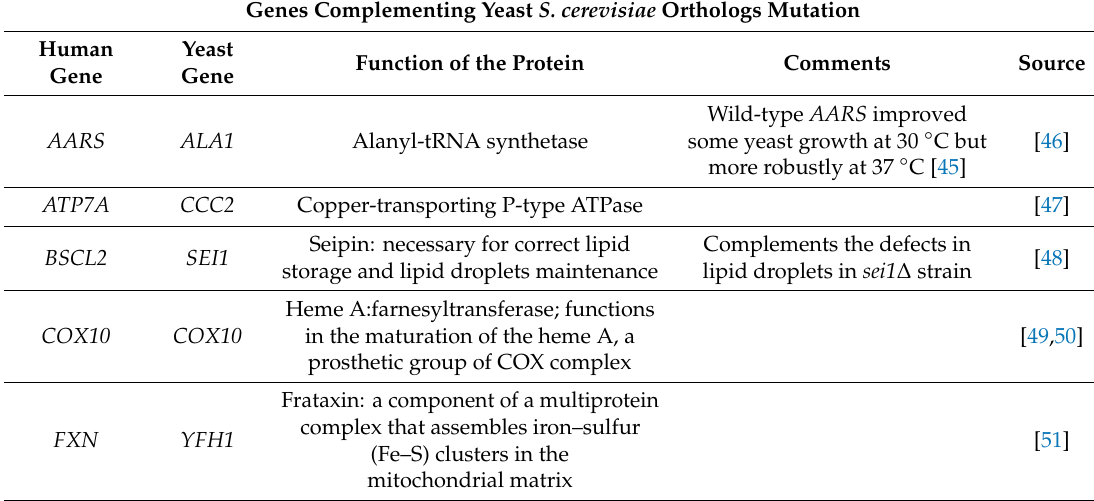
Table 1. Human Genes Associated with Neuropathies and Their Yeast